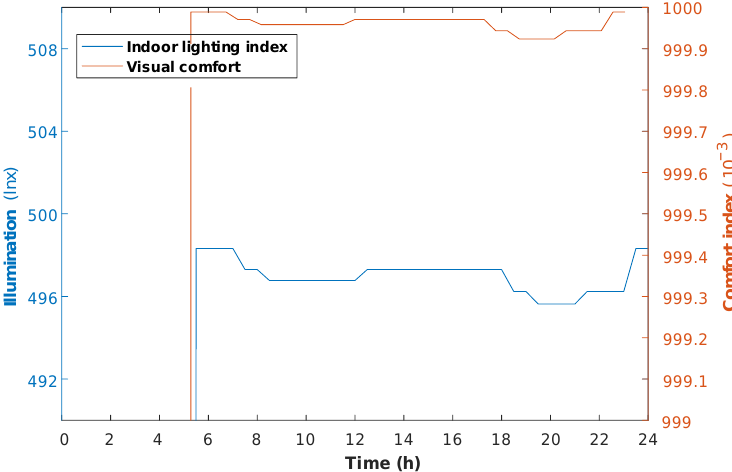
Figure 6. The results of the indoor lighting index and visual comfort of the commercial office building.